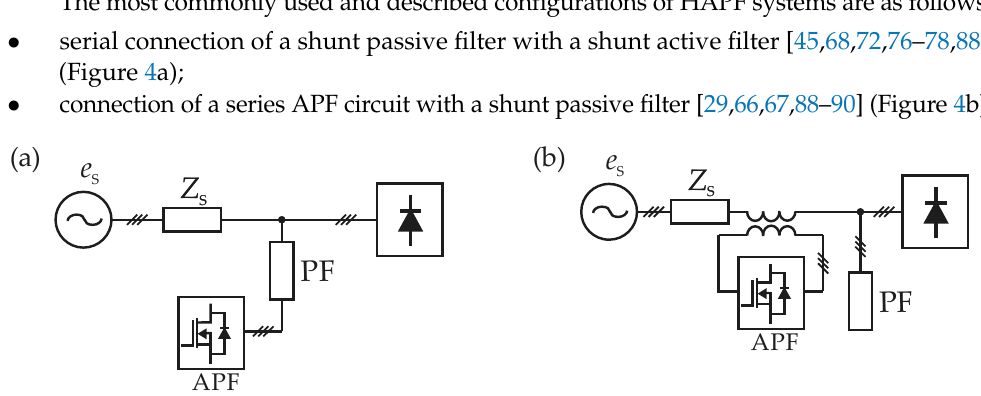
Figure 4. The most commonly used hybrid filter configurations: ( a ) with shunt APF, ( b ) with series APF.